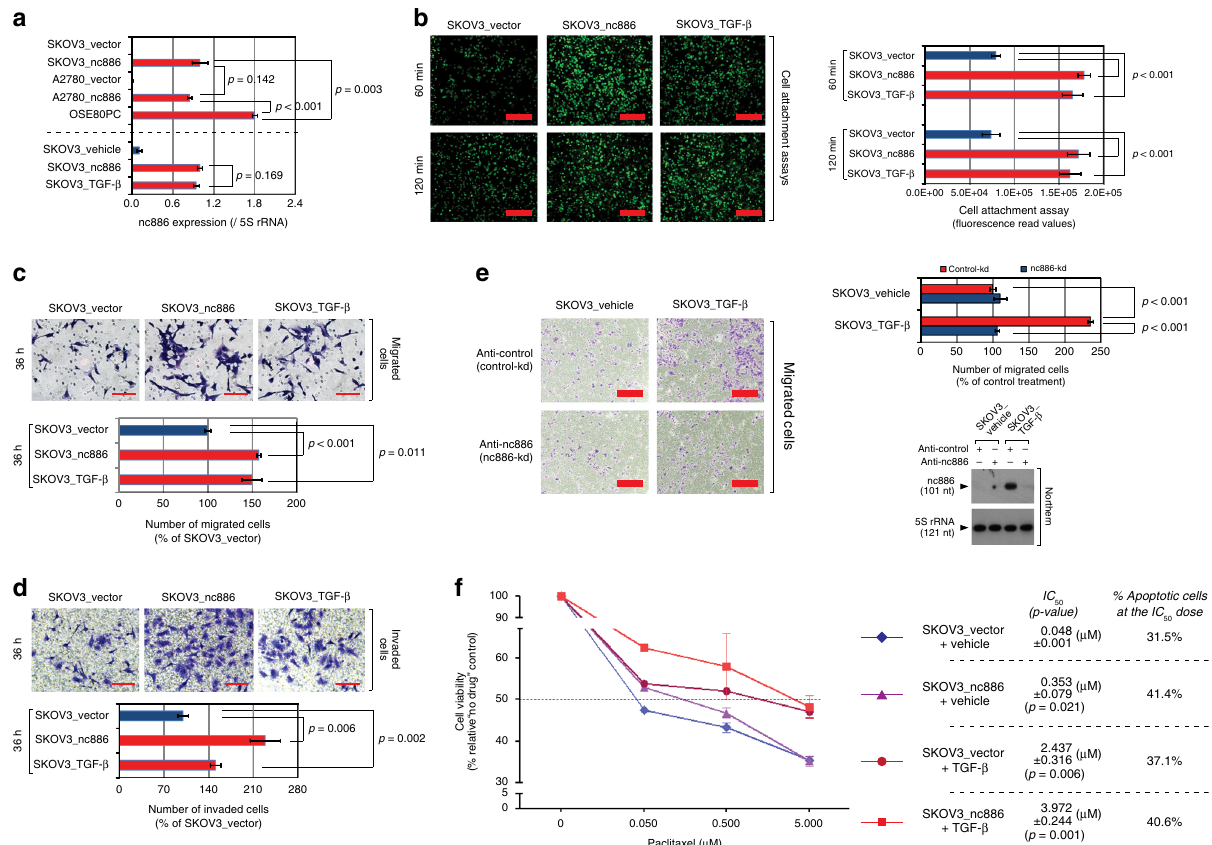
Fig. 2 nc886 phenocopies TGF- β in promoting OC metastatic capability. a nc886 expression level quanti fi ed from northern hybridization. A representative image is Supplementary Fig. 5b. See text and Supplementary Fig. 5a for cell line designation. “ SKOV3_TGF- β ” indicates SKOV3_vector cells treated with TGF- β . b – d Cell attachment ( b ), migration ( c ), and invasion ( d ) assays. In each panel, representative images and quanti fi cation graphs are shown. In images, red thick bars indicate 1 mm ( b ) and red thin bars indicate 100 μ m ( c , d ). The graphs display an average and the standard deviation from pentaplicates. e Cell migration assays upon combined treatment. The order of treatment was: TGF- β for 96 h, transfection with siPKR for 24 h, and nc886 kd for 18 h. Representative images, quanti fi cation graphs, and northern hybridization are shown. Red tick bars indicate 1 mm. f Percent cell viability (calculated from MTT values) is plotted against paclitaxel concentration. The concentrations for 50% cell death (IC 50 in µ M) and % apoptotic cells (from Supplementary Fig. 9) are indicated on the